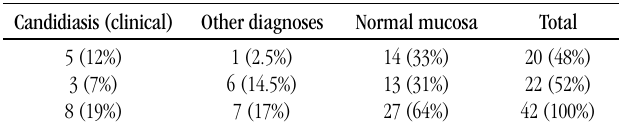
tABLE 1 – Sample distribution according to clinical characteristics